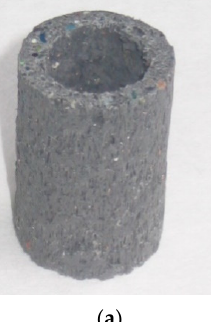
Figure 3. Step-by-step preparation of material for the active filling.